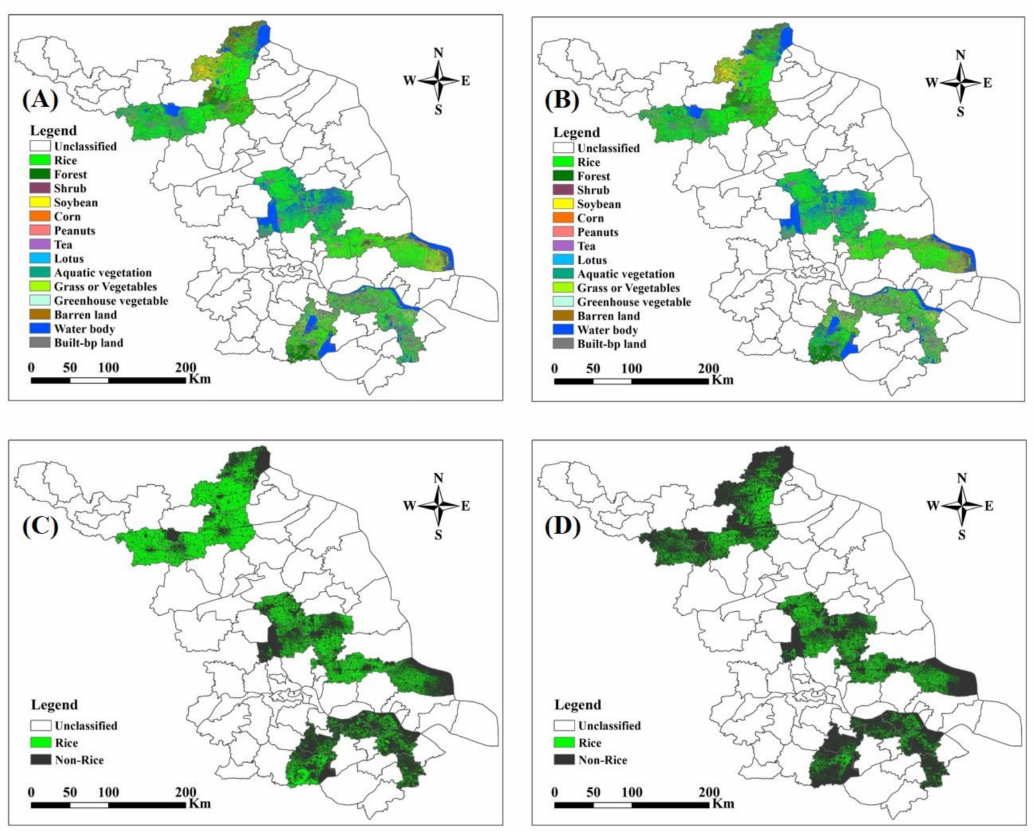
Figure 8. Rice classification maps of 18 counties in Jiangsu Province, China with the methods ( A ) MCSVC; ( B ) DTC; ( C ) VIT; and ( D )